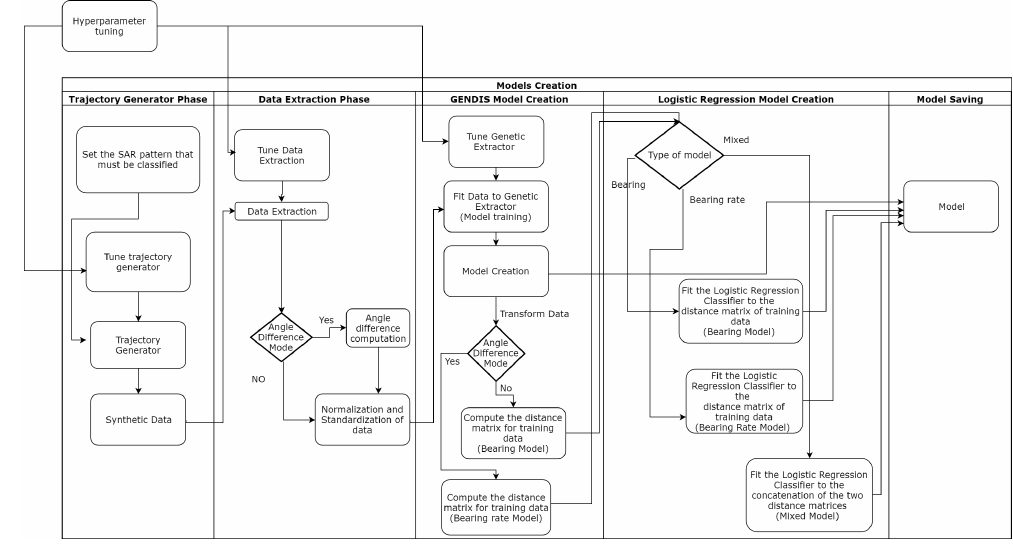
Figure 2. The workflow of the model creation